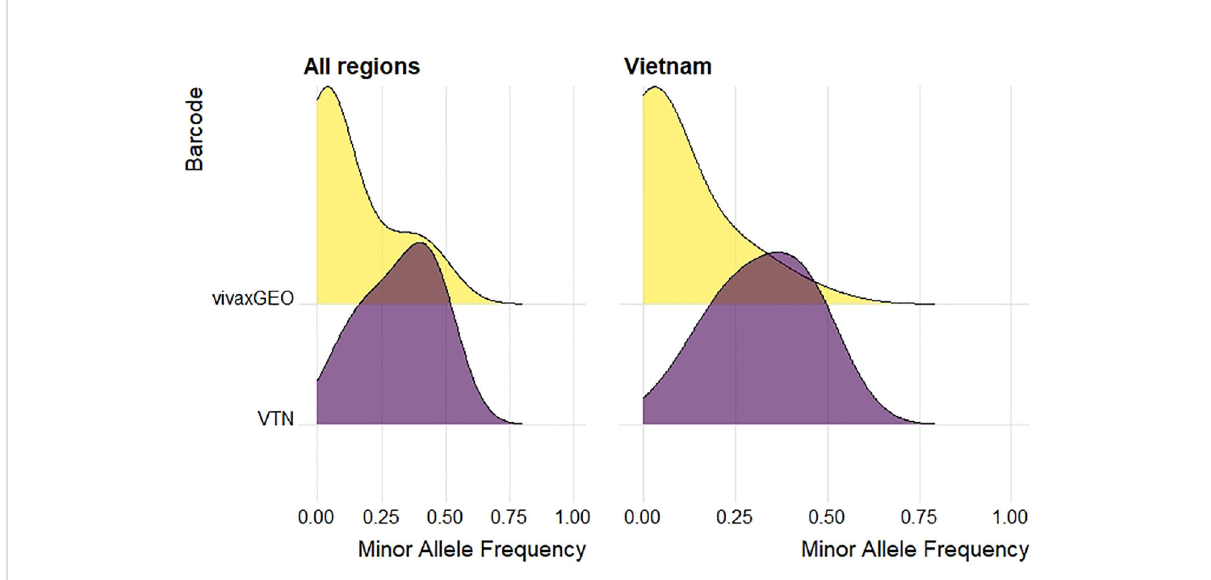
FIGURE 3 Density plot of minor allele frequencies of 33-SNP vivaxGEN-geo barcode (yellow) and 42-SNP within-country Vietnam barcode (purple) in samples tested with the Pv AmpliSeq assay. Minor allele frequencies were calculated in study samples in all regions (n=394, left) or in Vietnam only (n=261,